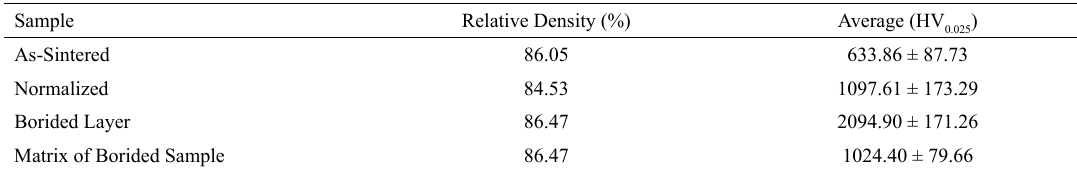
Table 4. Vickers microhardness of each condition in study